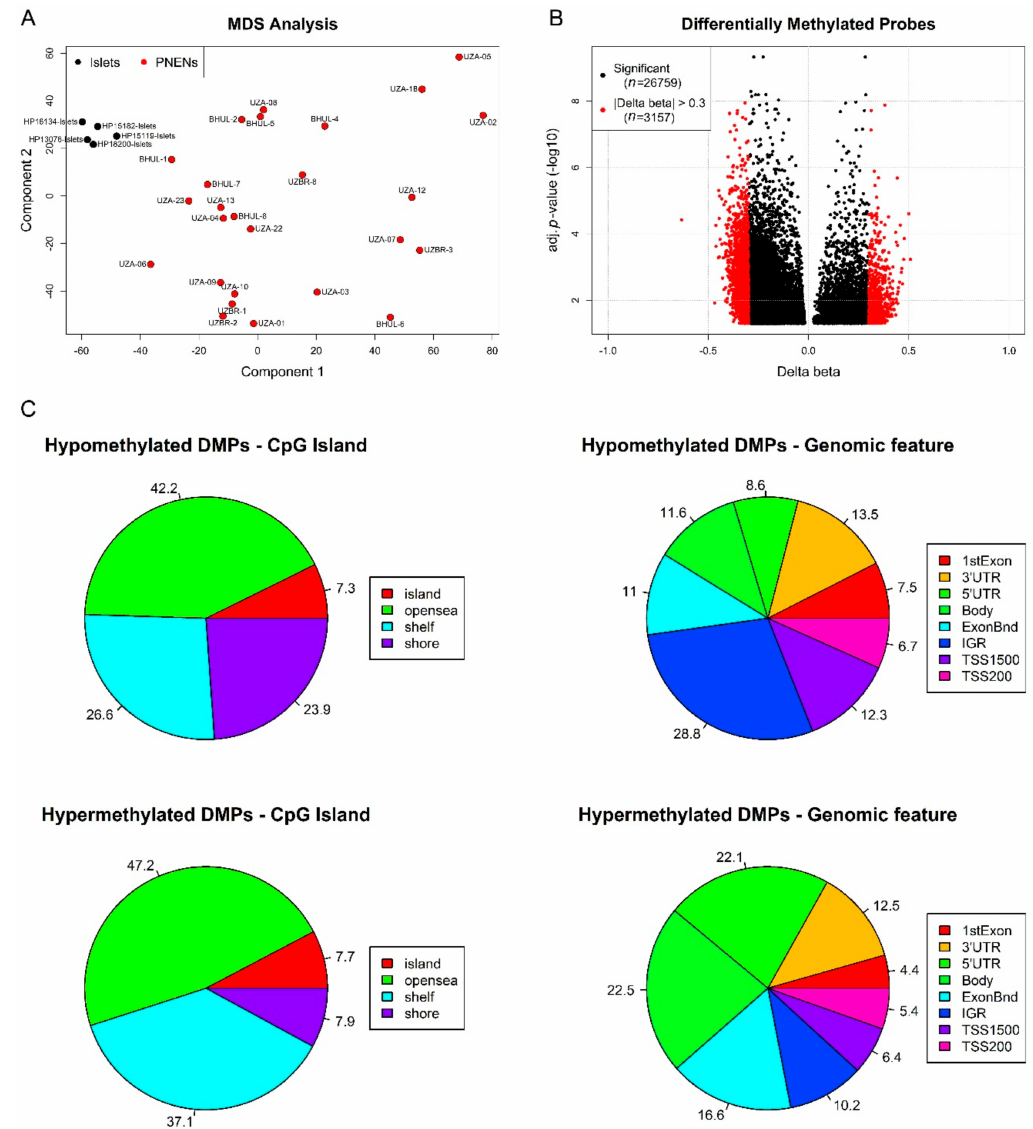
Figure 2. Exploratory analysis of EPIC DNA methylation data of 26 PNENs and 5 pancreatic islets. ( A ) Multidimensional scaling (MDS) analysis shows how PNENs (red) cluster separately from the pancreatic islets (black). ( B ) Volcano plot of all di ff erentially methylated probes (DMPs) (black), the DMPs with a delta beta (di ff erence in methylation between normal and tumor) greater than 0.3 are highlighted in red. ( C ) The distribution of hypo- and hypermethylated DMPs according to CpG island feature (island, open sea, shelf, shore) on the left and according to genomic feature (1 st exon, 3 (cid:48) untranslated region (UTR), 5 (cid:48) UTR, body, exon boundary (ExonBnd), intergenic region (IGR), transcription start site (TSS) 1500 (200–1500 bases upstream of TSS) and TSS200 (0–200 bases upstream of TSS) on the